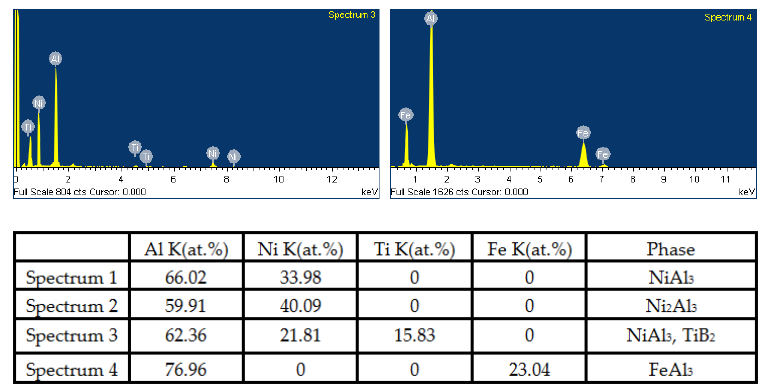
Figure 15. Cross-sectional morphologies and compositions of Ni/Al-TiB 2 coatings as-sprayed at 450 °C and after annealing at 650 °C for 30 h: ( a ) 200×, ( b ) 500×, and ( c ) 1000×.